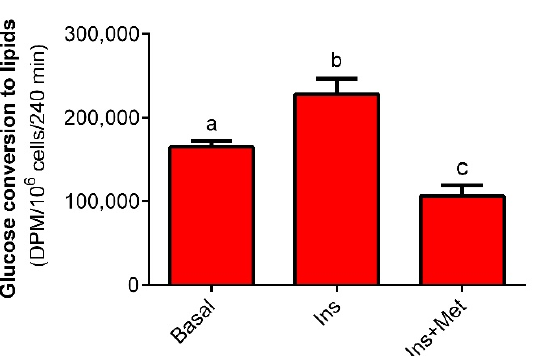
Figure 1. The effects of metformin on glucose conversion to lipids in isolated rat adipocytes. Adipocytes were incubated in a buffer containing 3 mM glucose, glucose D-[ 14 C(U)], 3% BSA, and 10 mM HEPES. Adipocytes were incubated without insulin (basal lipogenesis) or in the presence of 10 nM insulin (stimulated lipogenesis). To study the effects of metformin on insulin-induced lipogenesis, cells were incubated with insulin and 1 mM metformin. After the end of the incubation, total lipids derived from glucose were extracted, and their radioactivity was measured. Ins—insulin, Met—metformin, DPM—disintegrations per minute. The obtained results represent the mean ± SEM from 3 independent experiments in 5 repetitions ( n = 15). Values marked by different letters differ significantly at p < 0.05.